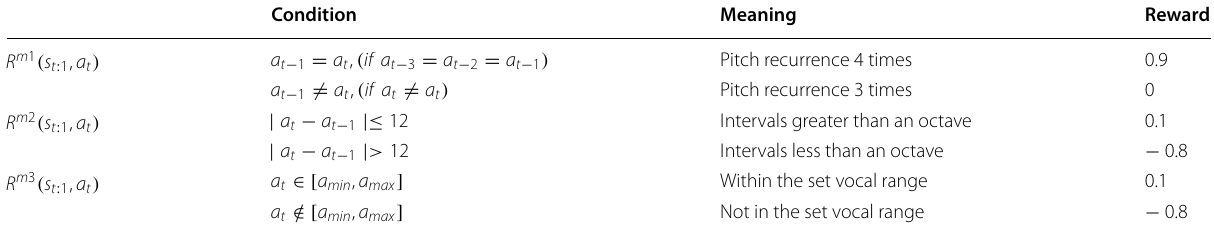
Table 1 Basic music theory reward